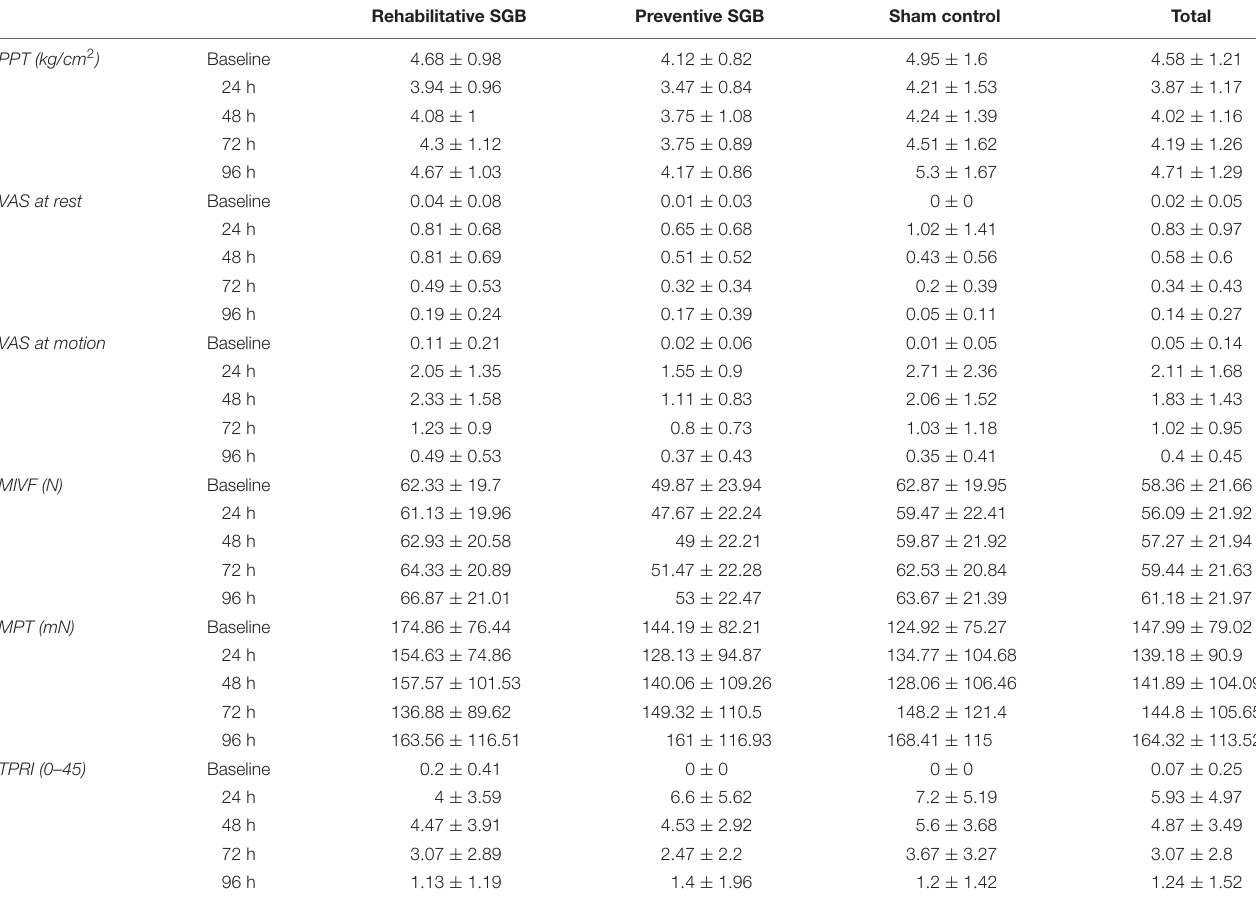
TABLE 2 | Outcome